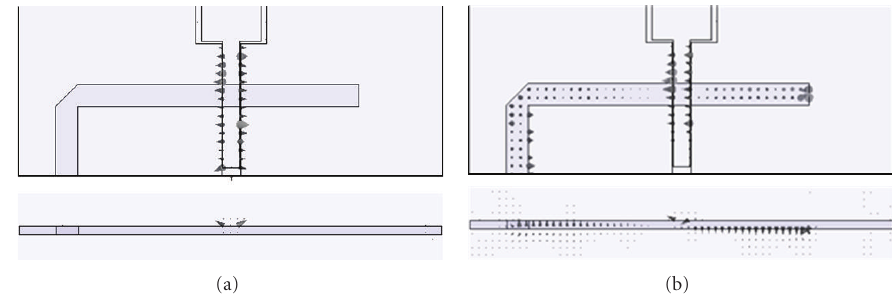
Figure 5: Electric field distribution with di ff erent feeding ports: (a) CPW and (b) microstrip.